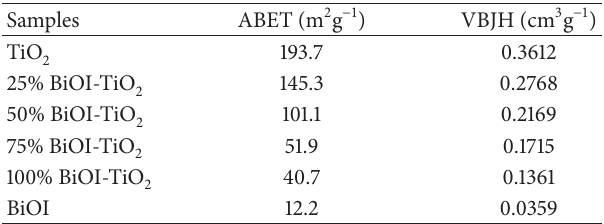
Table 1: Textural properties of BiOI-TiO